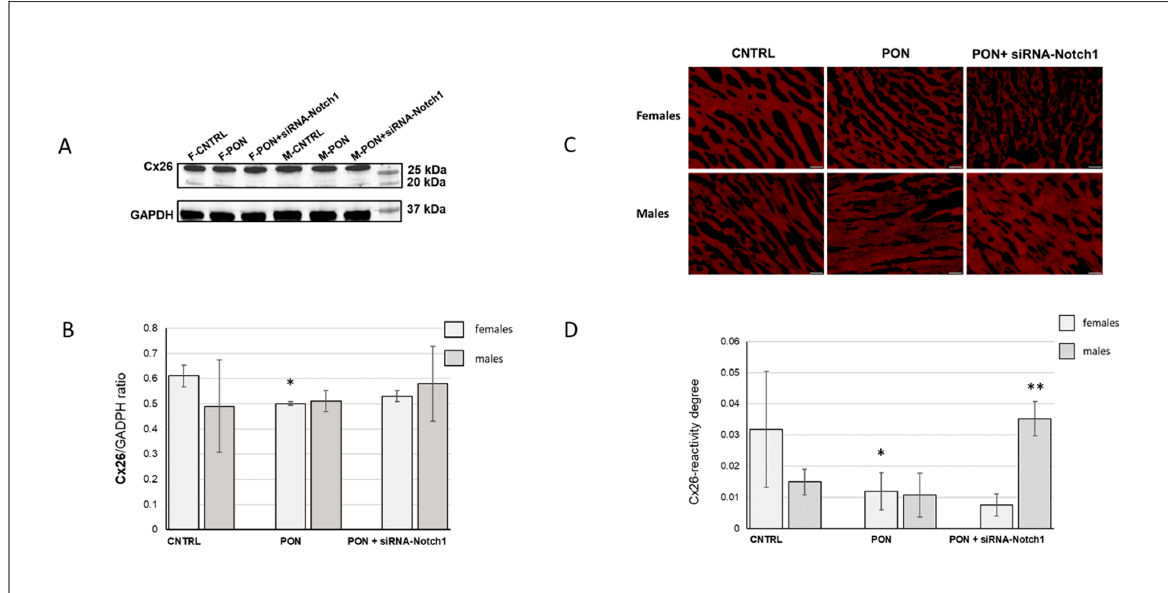
Figure 7. Cardiac Cx26 protein expression. ( A ) Representative of a Western blot analysis of one group of the three analysed groups. ( B ) Histogram obtained by Western blot analysis, representing the total cardiac Cx26 protein expression of heart mice samples. ( C ) Immunofluorescence staining: representative images of cardiomyocyte Cx26 immunoreaction (red). Magnification: 200×. Bars: 50 µm. ( D ) Image analysis of cardiomyocyte Cx26 immunostaining * p ≤ 0.05 vs. CNTRL and PON + siRNA-Notch1; ** p < 0.01 vs. CNTRL and PON + siRNA-Notch1.